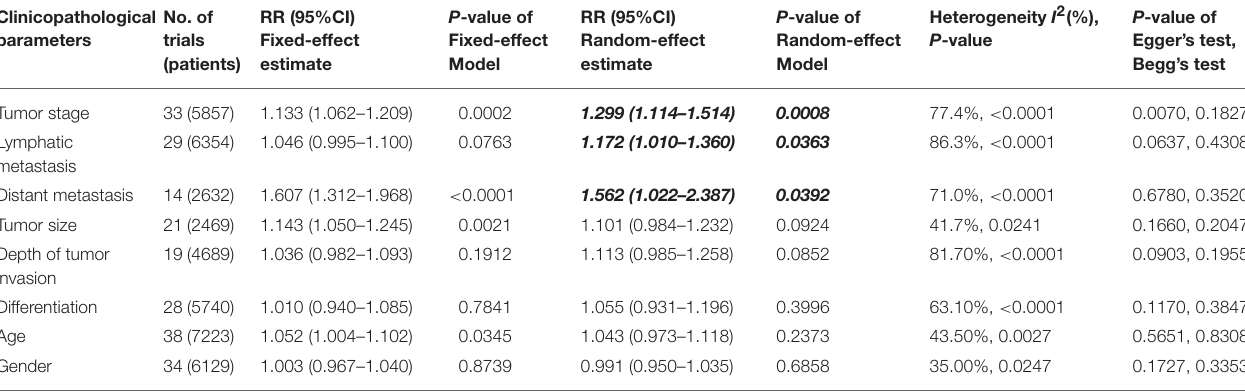
TABLE 3 | The associations of SIRT1 overexpression with the clinicopathological characteristics of the study patients. Clinicopathological